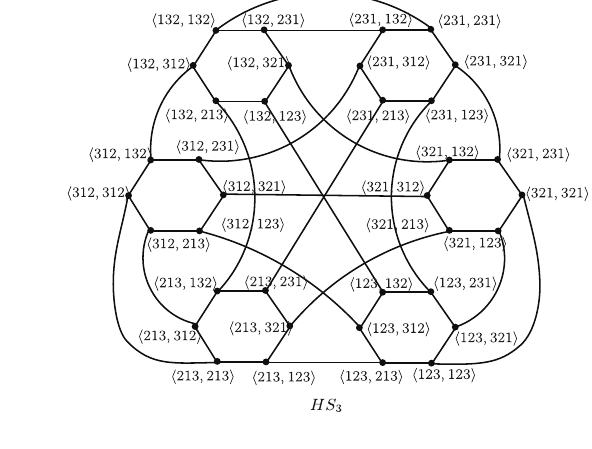
Figure 2: The graph of HS 2 and HS 3